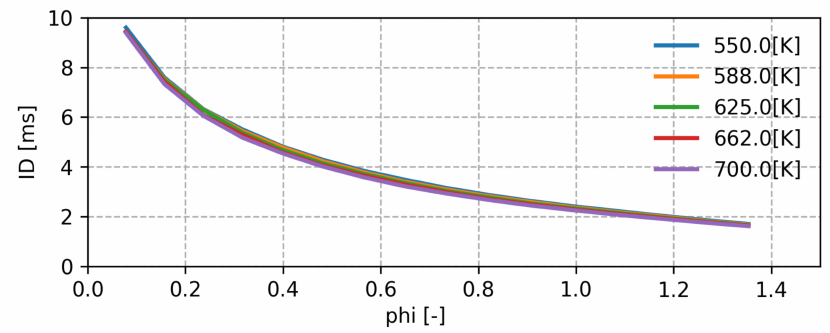
Figure 4. ID sensitivity of iso-octane with φ for different fuel